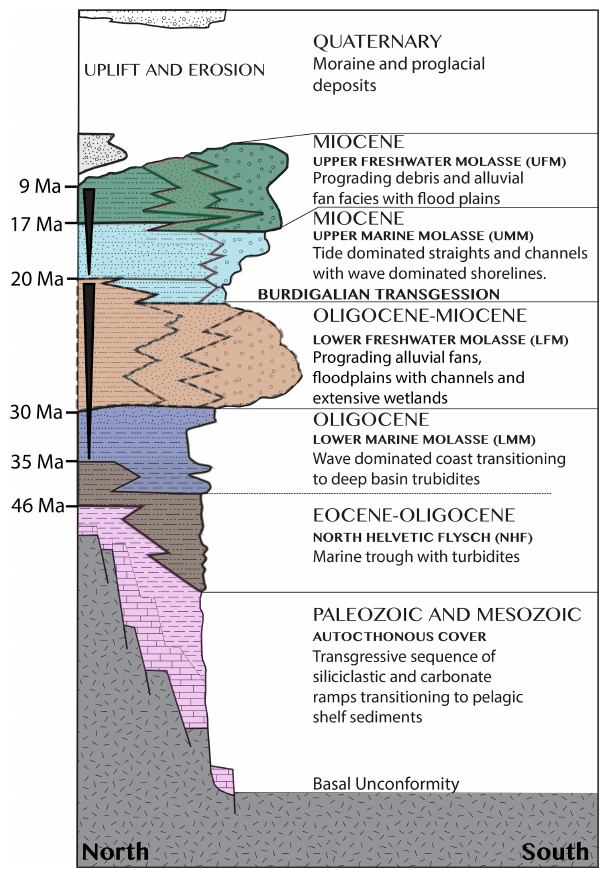
Figure 2. Generalized stratigraphy of the Molasse Basin. Modi- fied from Keller (2000). Black arrows indicate the two large-scale shallowing- and coarsening-upward sequences discussed in detail in Sect.